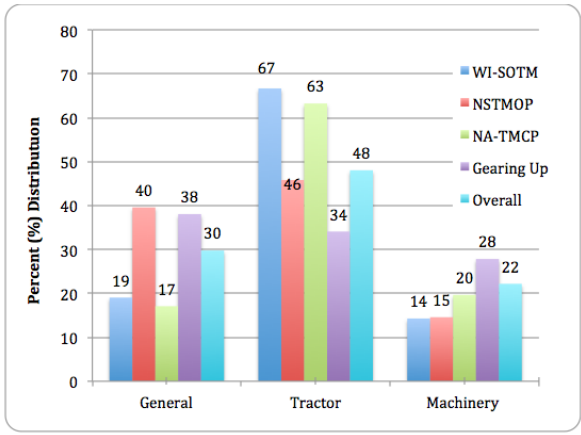
Figure 3. Distribution of Primary Categories across the Four Programs.